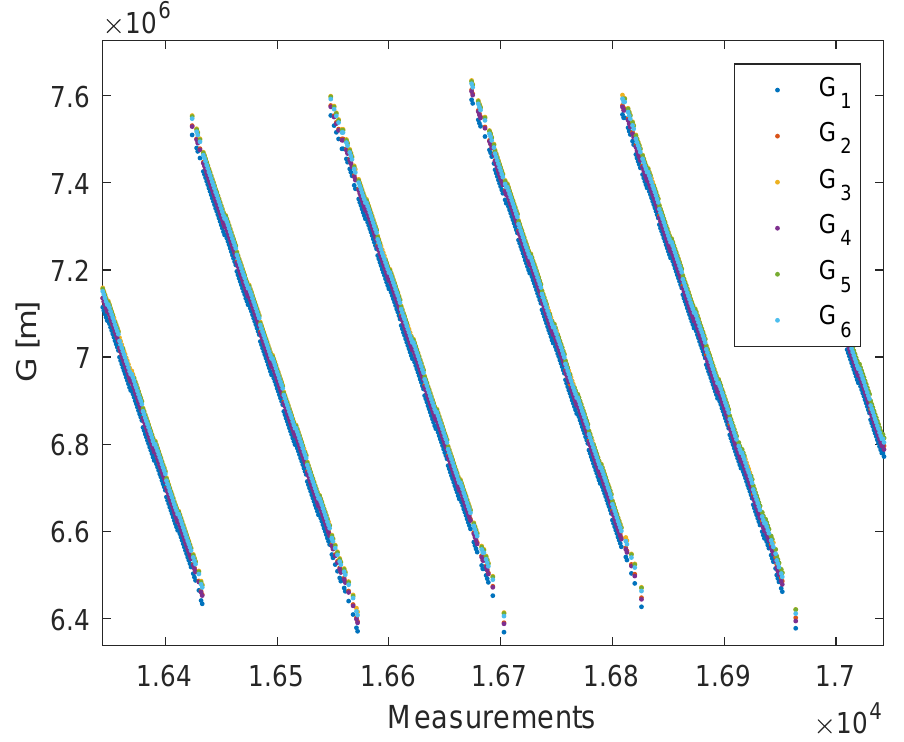
Figure 6. Zoom-in of the raw LPM measurements. The different colors represent the outcomes of the raw measurements before every station is subtracted from Station